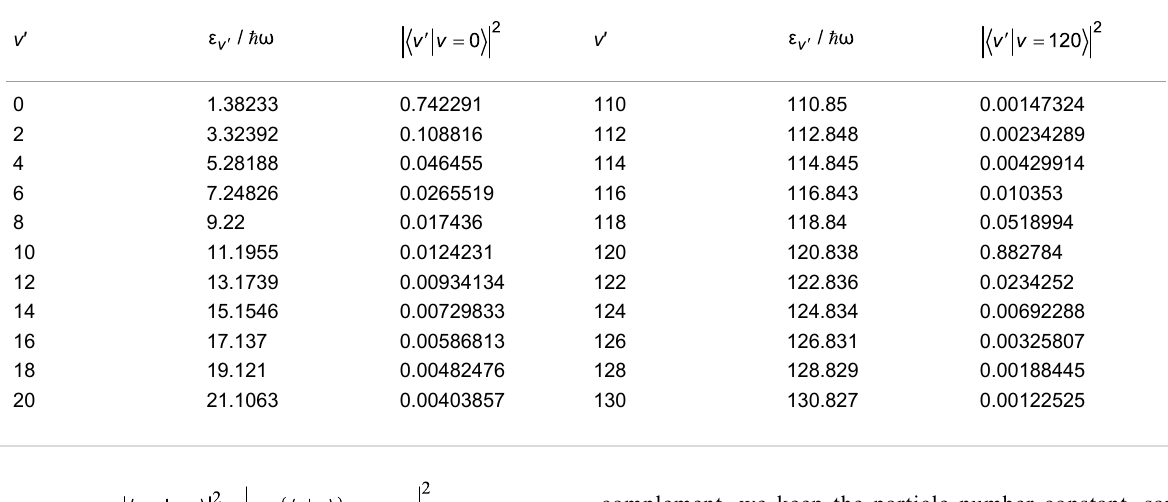
Table 2: Squared overlap integrals in a spin 1/2 trapped gas of 122 particles with a sudden switching impurity potential characterized by the critical exponent value α = 0.1 (see also Figure 3). The lowest occupied ( v = 0, ε 0 = 0.5 eV) and highest occupied ( v = 120, ε 120 = ε F = 120.5) states are mostly correlated to the corresponding perturbed states. Shake-up effects though involve the perturbed states which are closer in